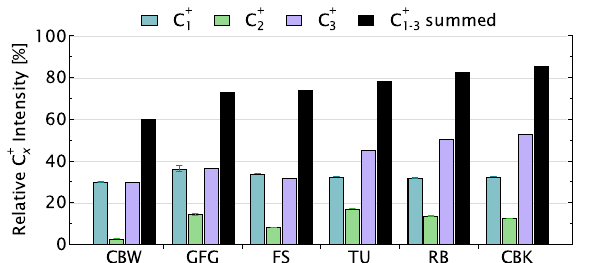
Fig. 3. Percentage contribution of C + ions to the sum of C + x sig- 1–3 nals (1 < x < 16) for CAST “Brown” (CBW), spark-generated par- ticles (GFG), fullerene-enriched soot (FS), aircraft-turbine particles (TU), Regal Black (RB), and CAST “Black” (CBK), in order of increasing C + intensity. Error bars for C + to C + are propagated 1–3 1 3 from Poisson ion counting statistics. The data represent an average over all selected